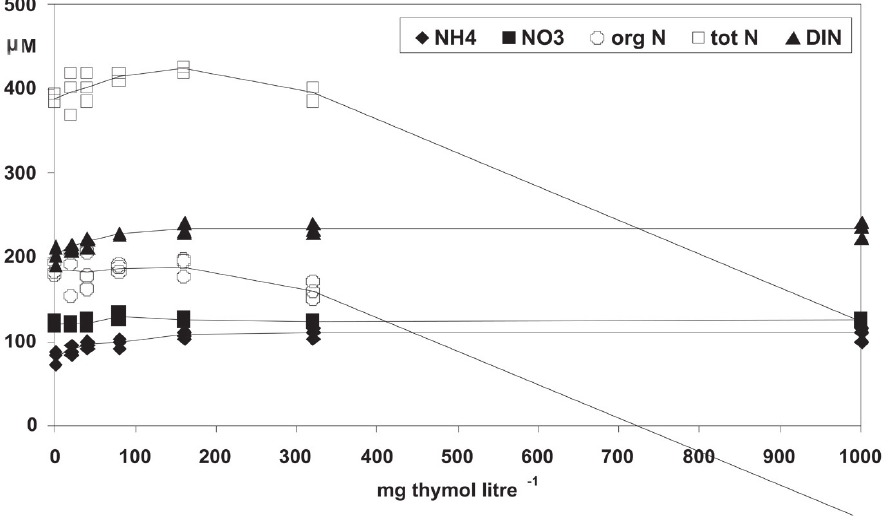
FIGURE 2. Test of thymol as biocide. Rain sample analysed after storage for 1 week with different amounts of thymol